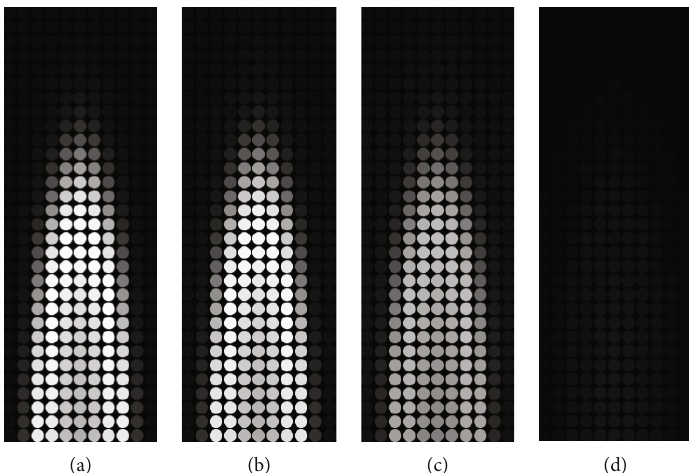
Figure 8: The light fi eld images of the fl ame with extinction coe ffi cient (a) β = 0 : 001mm − 1 , (b) β = 0 : 01 mm − 1 , (c) β = 0 : 1mm − 1 , and (d) β = 1mm − 1 .